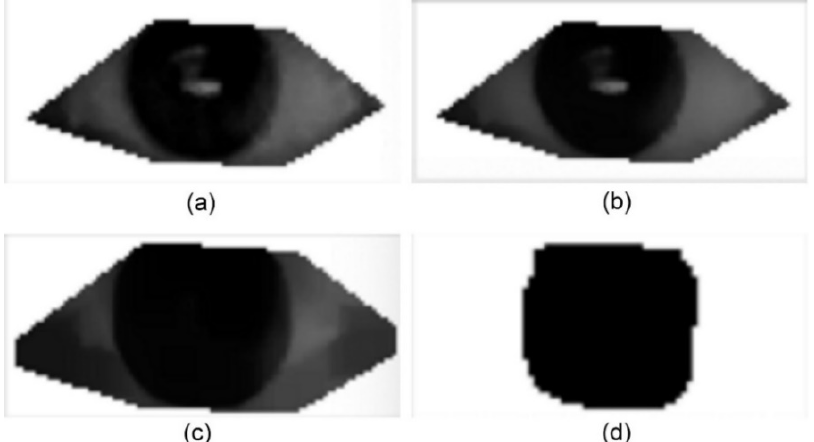
Figure 2. Processing results for an eye region. ( a ) grayscale eye image, ( b ) blurred eye image, ( c ) eroded eye image, and ( d ) binarized eye